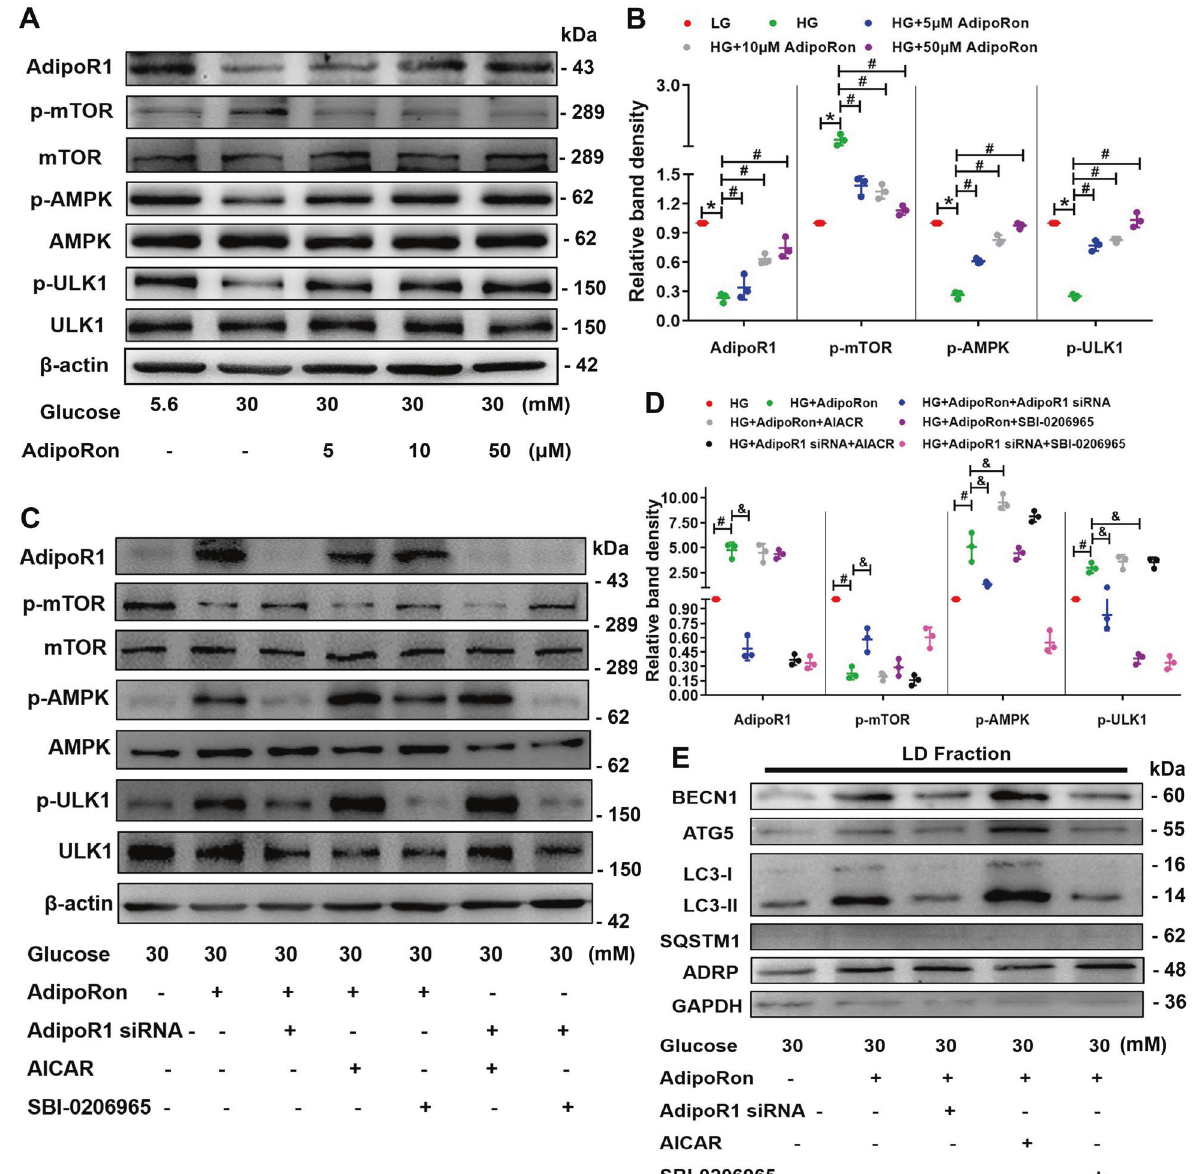
Fig. 6 AdipoRon increased lipophagy through AdipoR1/AMPK pathway. WB and densitometric analysis of AdipoR1, p-mTOR, p-AMPK and p-ULK1 expression in HK-2 cells exposed to HG conditions with or without different AdipoRon concentrations ( A , B ). WB and densitometric analysis of AdipoR1, p-mTOR, p-AMPK and p-ULK1 expression in HK-2 cells exposed to an HG environment pretreated with AdipoRon, AdipoR1 siRNA, AICAR or SBI-0206965 ( C , D ). WB analysis of BECN1, ATG5, LC3 and SQSTM1 using isolated LD fractions from HK-2 cells exposed to HG conditions with or without AdipoRon, AdipoR1 siRNA, AICAR and SBI-0206965 ( E ). Values are the mean ± SD; * p < 0.05 versus LG group, # p < 0.05 versus HG group, & p < 0.05 versus HG + AdipoRon group. n =